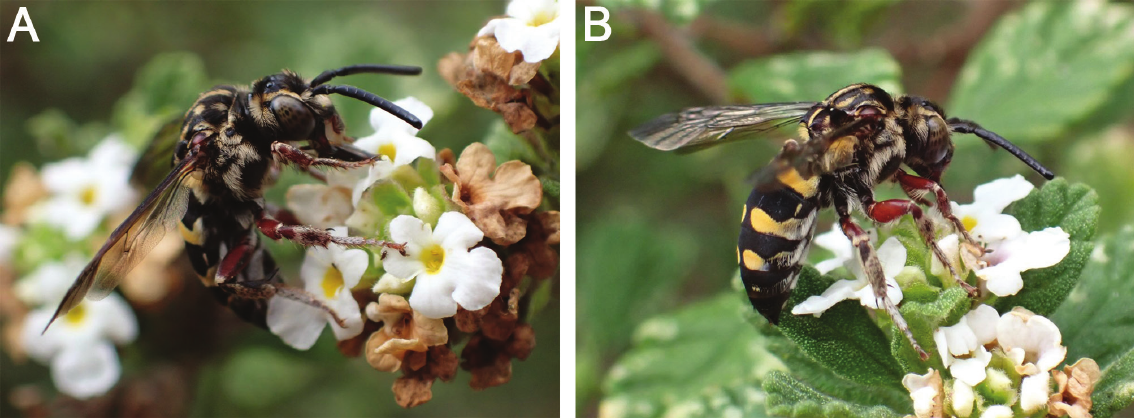
Fig. 11. Female Brachymelecta haitensis (Michener, 1948) taking nectar from flowers of Mexican oregano ( Lippia graveolens Kunth (Verbenaceae)) (location: Altamira, Puerto Plata, Dominican Republic). A . Shown with mouthparts extended into corolla. B . Shown with mesoscutellum and metasomal fasciae in view. Images courtesy of L. McDowell